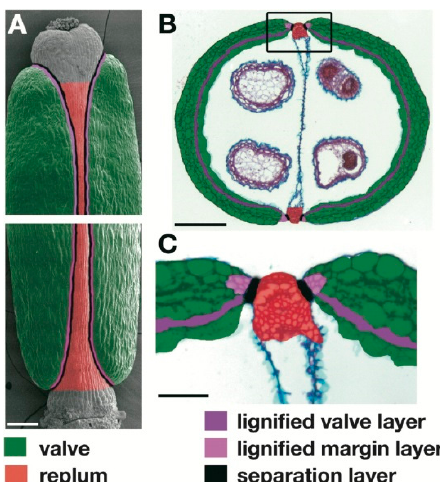
Figure 1. Representative scanning electron micrograph of mature wild-type fruit (stage 17) of A. thaliana . ( A ) Apex (top) and base (bottom) of fruit, with regions colored as indicated. ( B ) Transverse section with cell types colored corresponding to ( A ). Box: Valve margin region shown in ( C ). ( C ) Close up of valve margin region. Scale bars: 200 µ m, ( A , B ); 50 µ m; ( C ) (reproduced with permission from Liljegren et al. [8]).